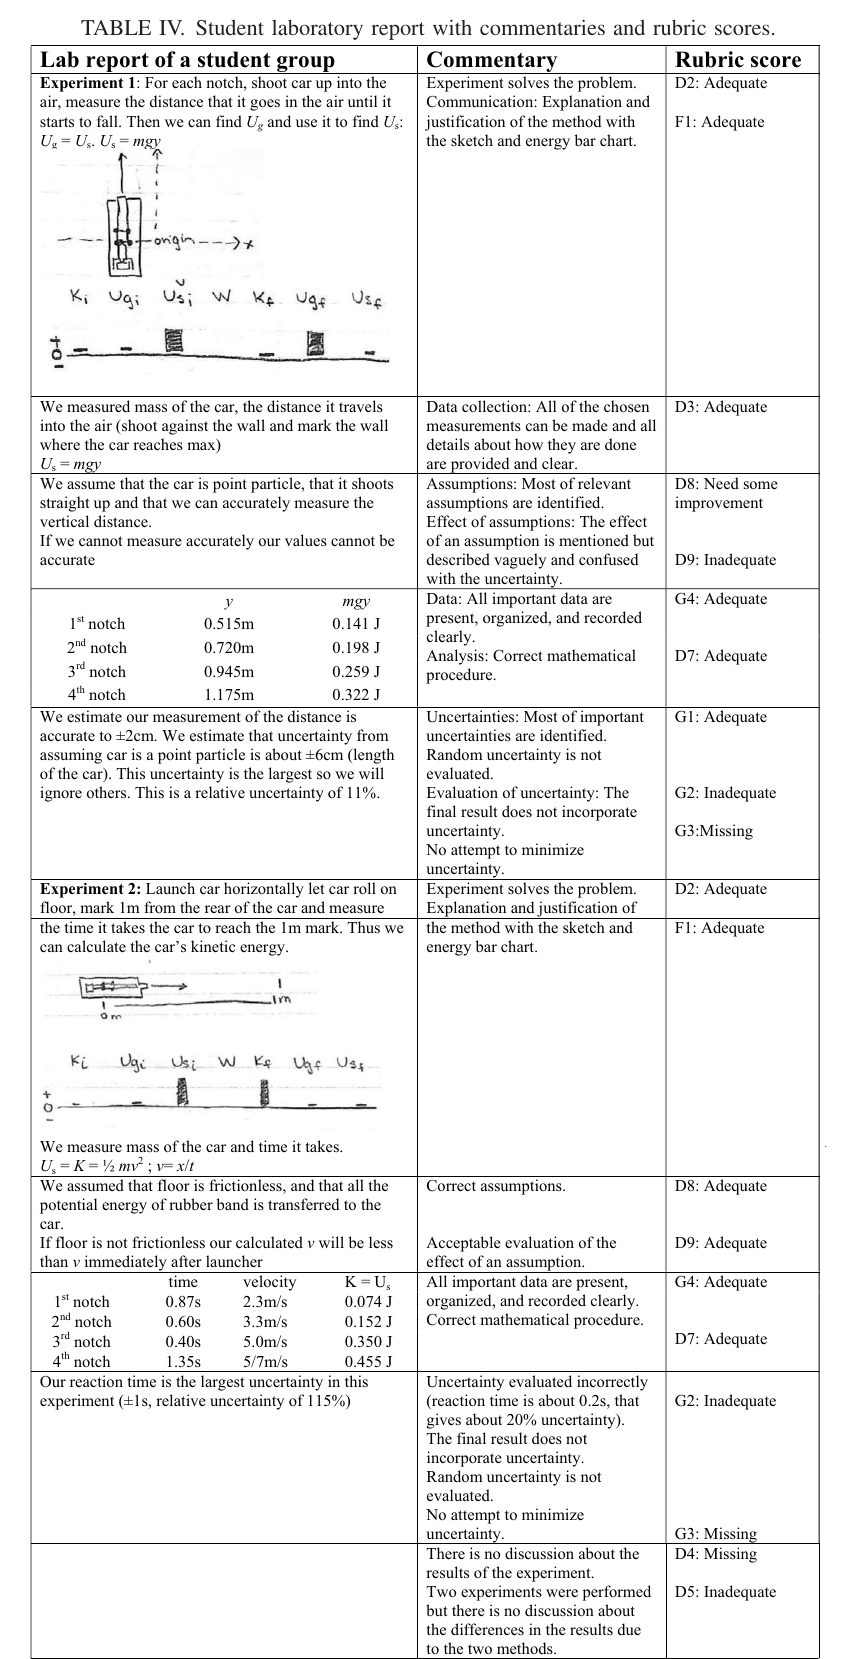
TABLE IV. Student laboratory report with commentaries and rubric scores. L ab report of a student group C ommentary